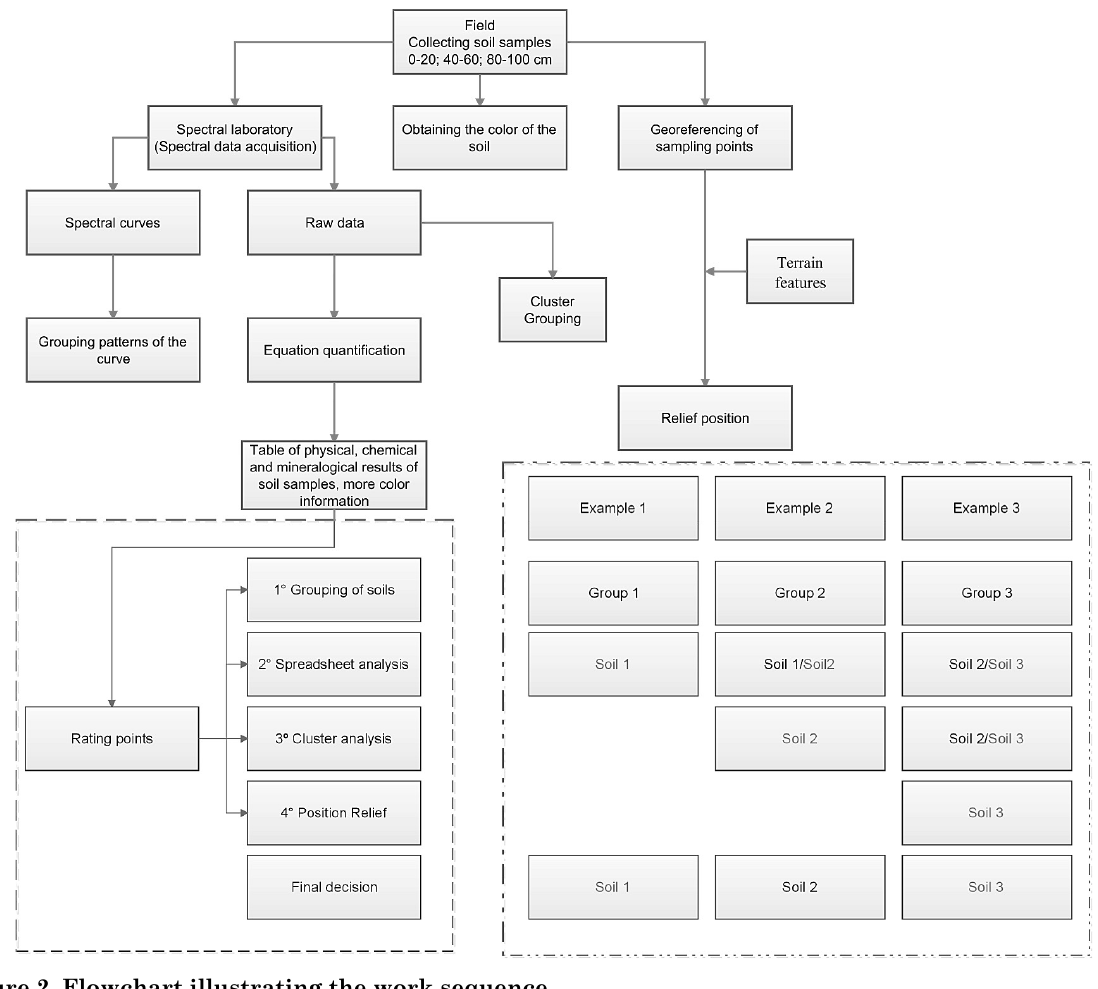
figure 2. flowchart illustrating the work sequence.